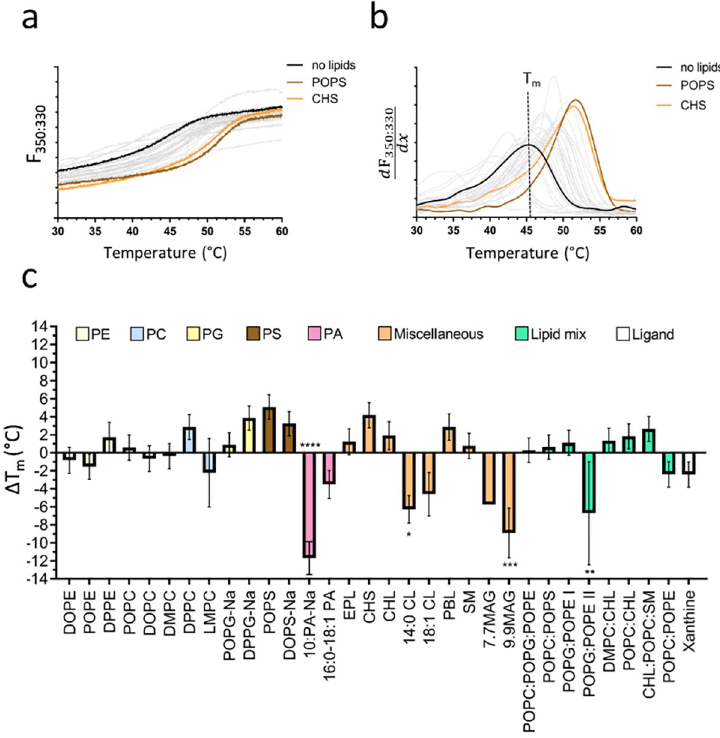
Fig 2. Lipid screening of UapA by nanoDSF. ( a ) F 350:330 signal of the no lipids reference sample (black line) and a representative set of stabilising lipids (coloured lines) during the melting scan. Grey lines show the fluorescence traces of the other tested lipids. ( b ) First derivative of the F 350:330 signal signal highlighting the fluorescence change indicative of protein unfolding. The T m can be determined at the curve peak, here shown for the no lipids reference sample as dotted line. ( c ) Δ T m of detergent-solubilised to relipidated sample shown for all tested lipids, which are sorted and colour coded according to their lipid class. Panel a-b show the traces of a representative nanoDSF scan. Panel c shows the Δ T m and corresponding SEM based on three technical repeats. The asterixis represent the p-value ( � = 0.0332, �� = 0.021, ��� = 0.002, ���� = 0.0001) obtained by a one-way ANOVA followed by a Dunnet test to correct for multiple comparison in GraphPadPrism